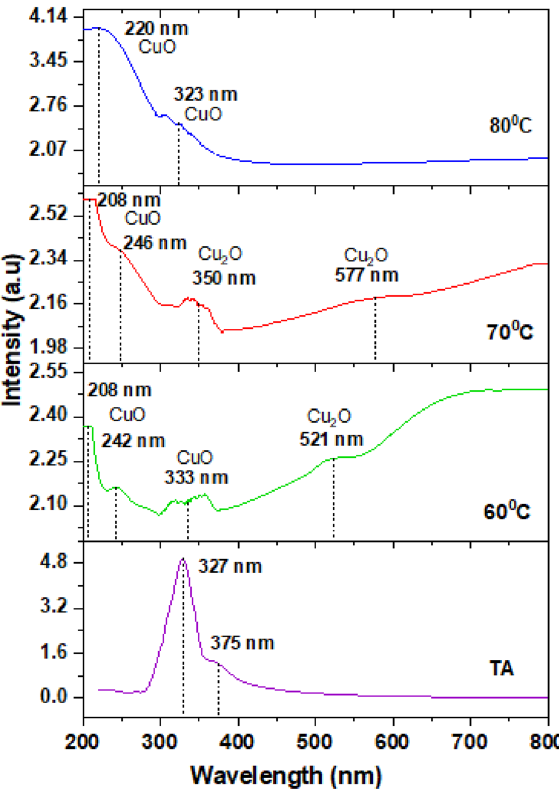
Figure 11. Absorbance spectra of the TA, the as-produced of CuO and Cu 2 O nanostructures prepared at 60, 70 and 80